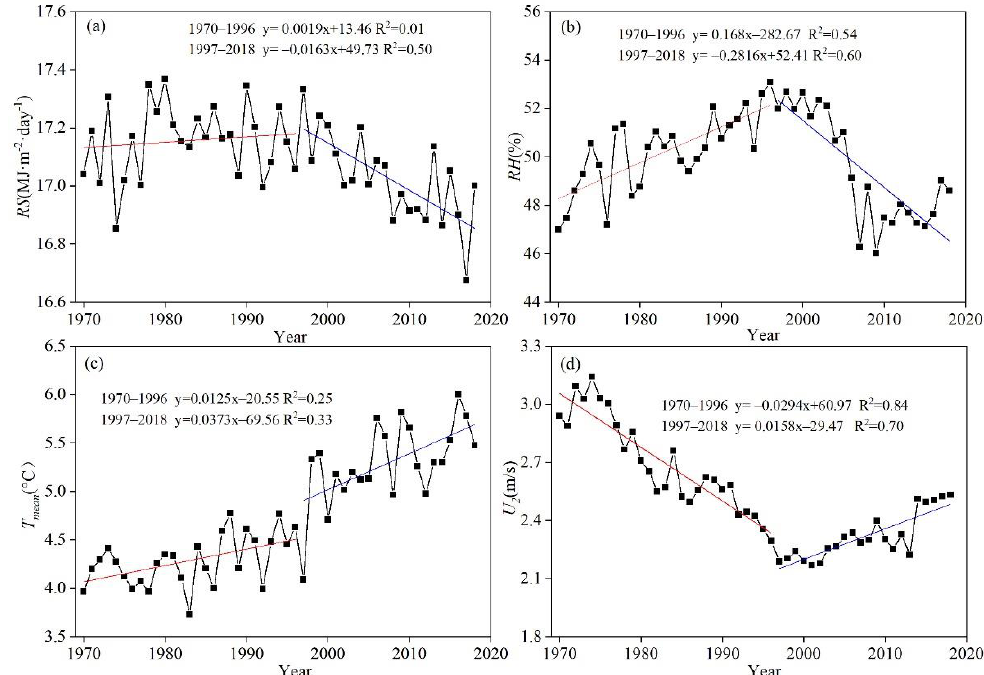
Figure 5. Annual variation of climatic factors on the TP during 1970 – 2018. ( a ) Solar radiation ( RS ); ( b ) relative humidity ( RH ); ( c ) air temperature ( T mean ); ( d ) wind speed ( U 2 ).